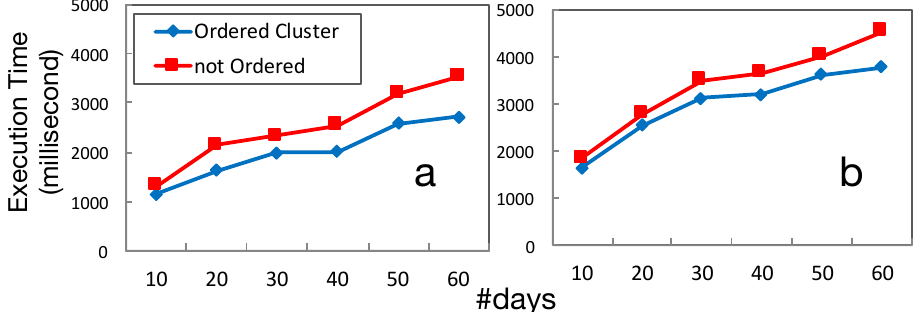
Figure 10. Improvement of search execution time (in milliseconds) by ranking clusters based on their number of contrast behaviors. ( a ) UbiqLog and ( b ) Device Analyzer